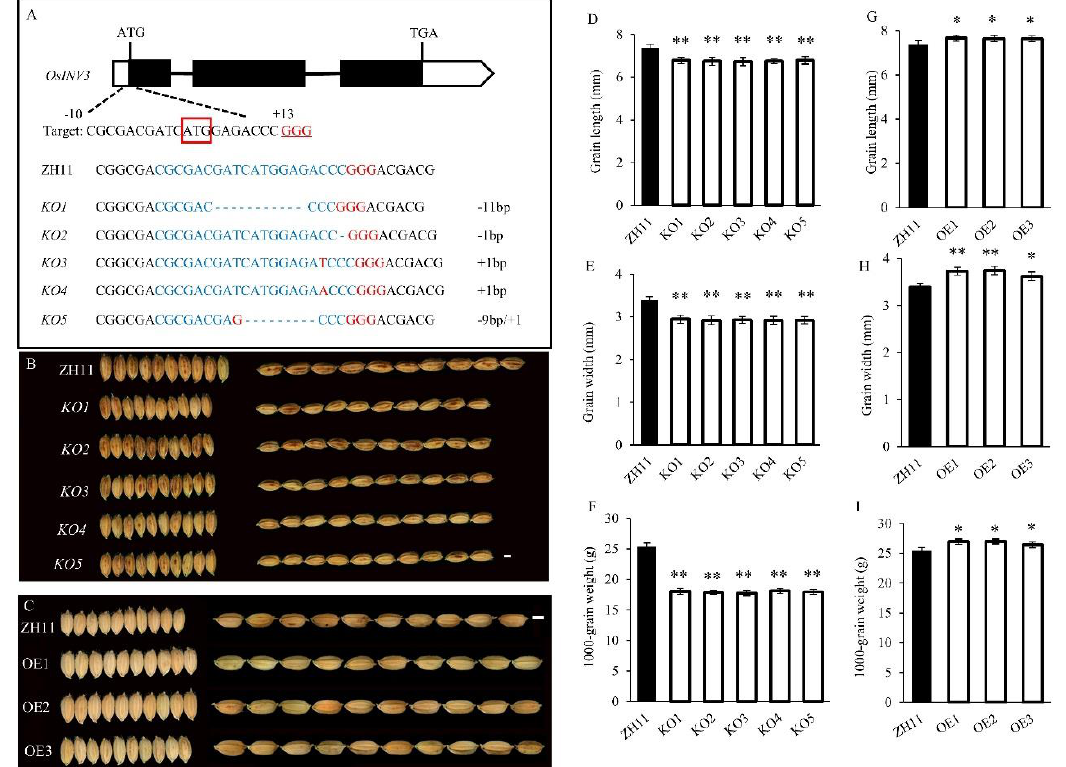
Figure 6. Genetic e ff ects of OsINV3 KOs and OEs on grain size. ( A ) Schematic map of the sgRNA target site in OsINV3 and sequence alignment for KOs (KO1–KO5). Black boxes, lines and white boxes represent exons, introns and the untranslated regions, respectively. The start codon (ATG) and the stop codon (TAG) are indicated. ( B ) Morphology of grain shape in ZH11 and KOs . Bar = 2 mm. ( C ) Morphology of grain shape in ZH11 and OEs (OE1–OE3). Bar = 2 mm. ( D – F ) Statistical data of the grain length ( D ), grain width ( E ), 1000-grain weight ( F ) in ZH11, KOs . ( G – I ) Statistical data of the grain length ( G ), grain width ( H ), 1000-grain weight ( I ) in ZH11, OEs. Data are given as means ± SD. Student’s t-test was used to generate the p values; **, * indicate p < 0.01, p < 0.05, respectively.